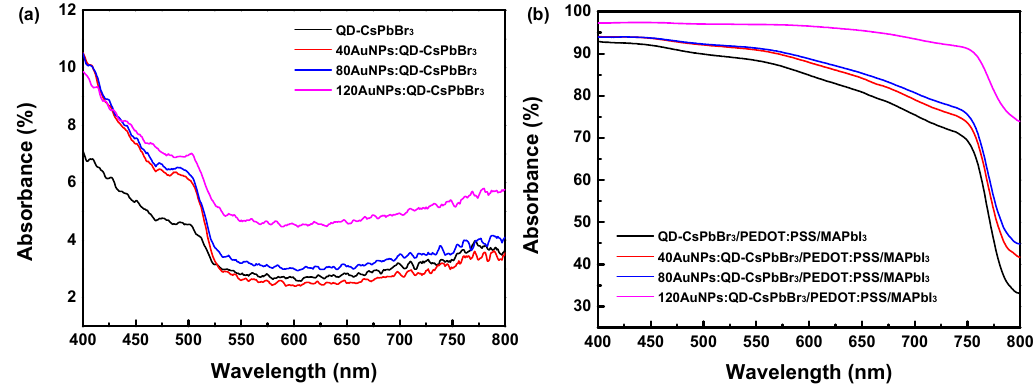
Figure 6. Absorbance spectra of ( a ) annealed QD-CsPbBr 3 , 40AuNPs:QD-CsPbBr 3 , 80AuNPs:QD- CsPbBr 3 and 120AuNPs:QD-CsPbBr 3 films, and of ( b ) AuNPs:QD-CsPbBr 3 / PEDOT:PSS / MAPbI 3 perovskite films with and without Au